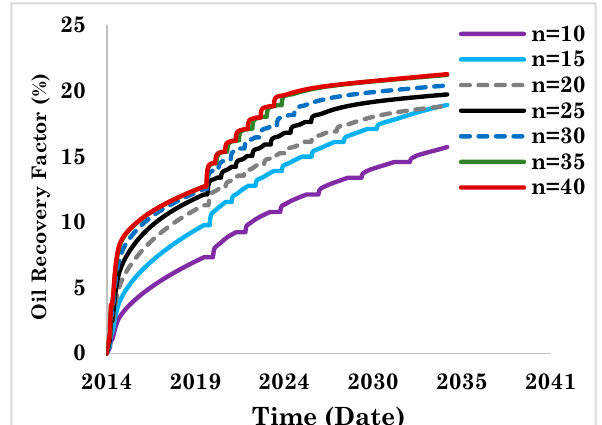
Figure 14. NG Injection (Fixed Cycle Size) 38 API Oil.